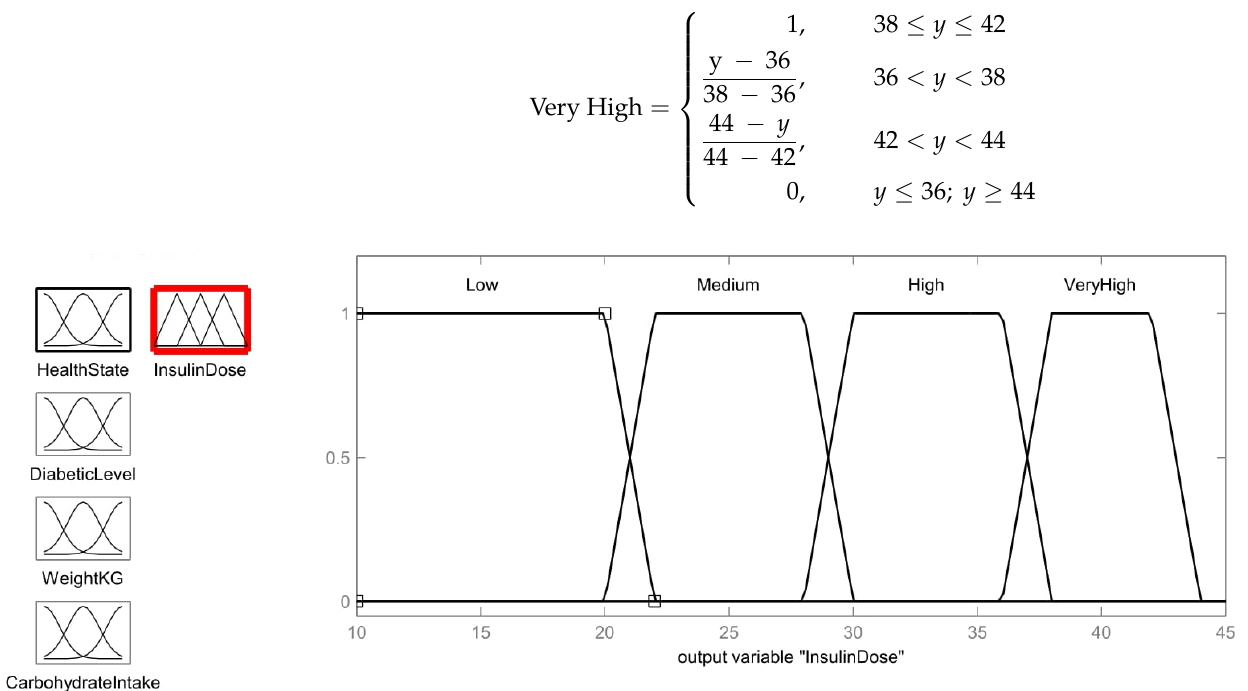
Figure 12. Insulin dose Membership function.